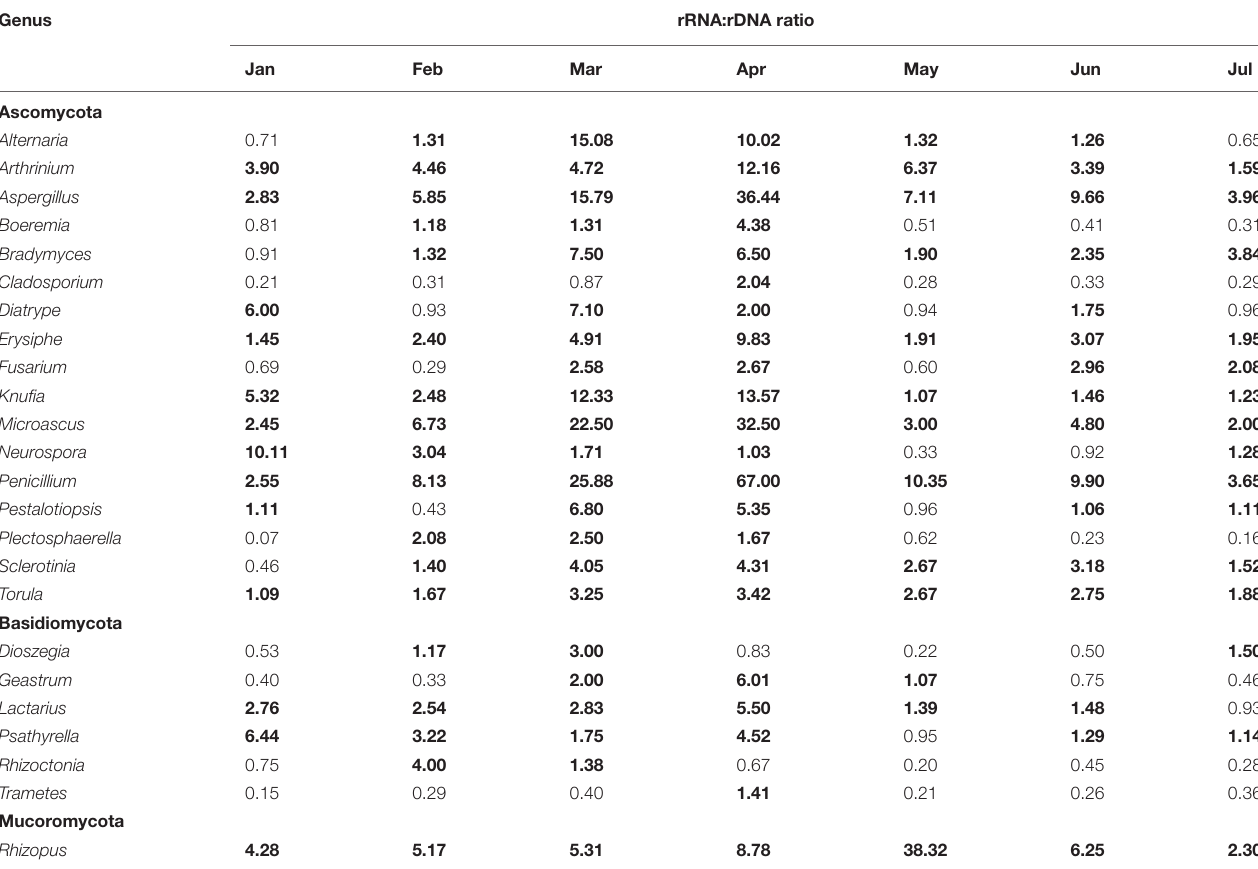
TABLE 2 | Temporal dynamics of the potential active of 23 core airborne fungal genera. Genus rRNA:rDNA ratio Jan Feb